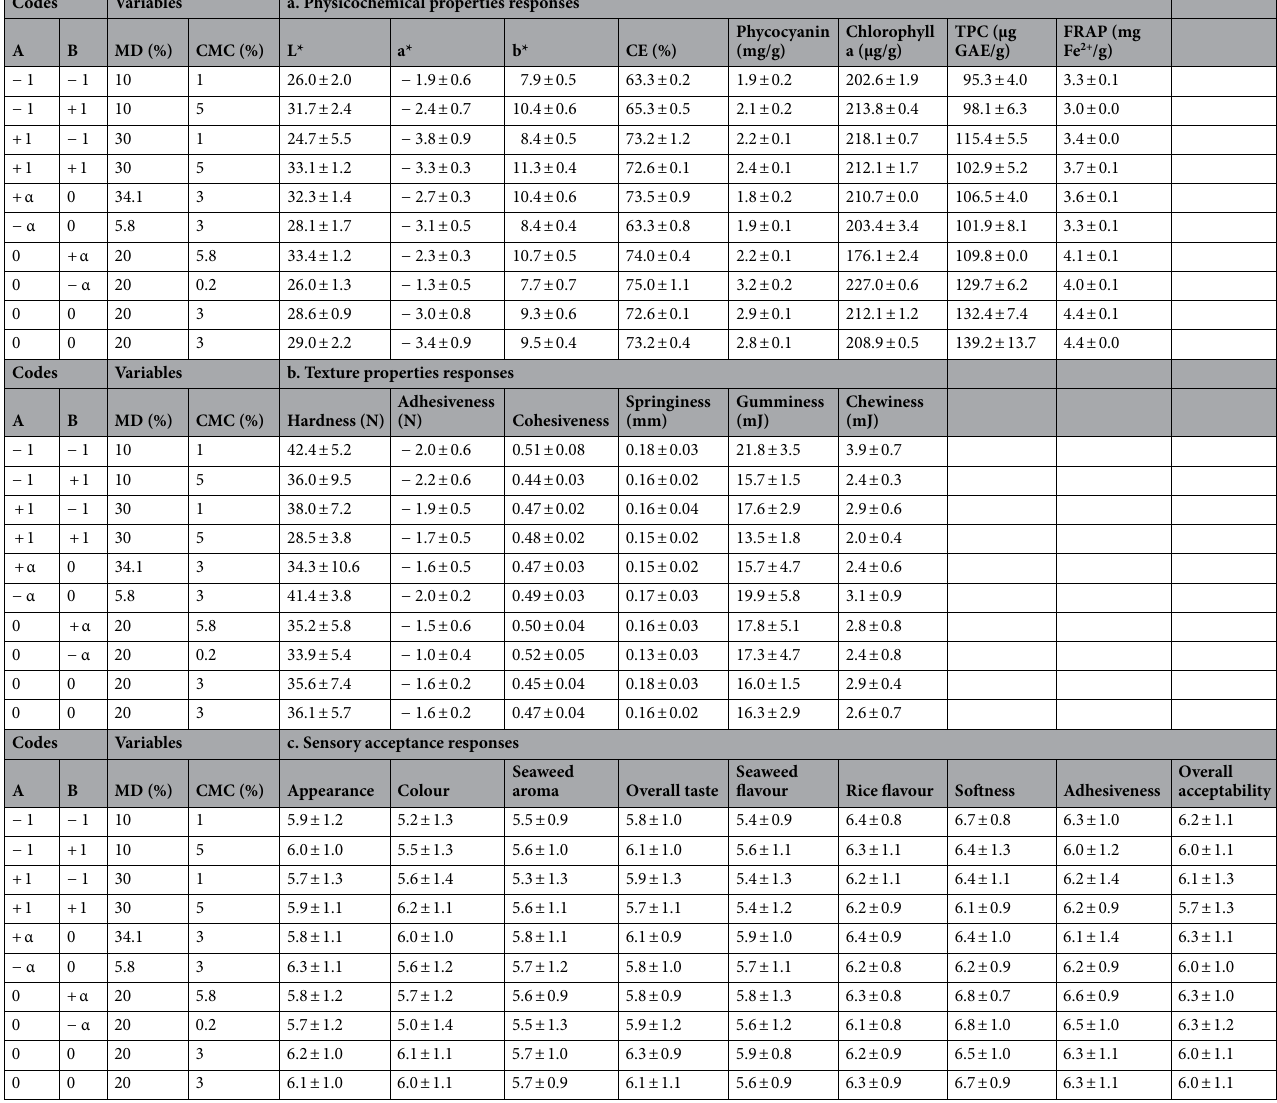
Table 1. Operation parameters and physicochemical properties, textural properties, and sensory acceptance responses of coated instant rice by